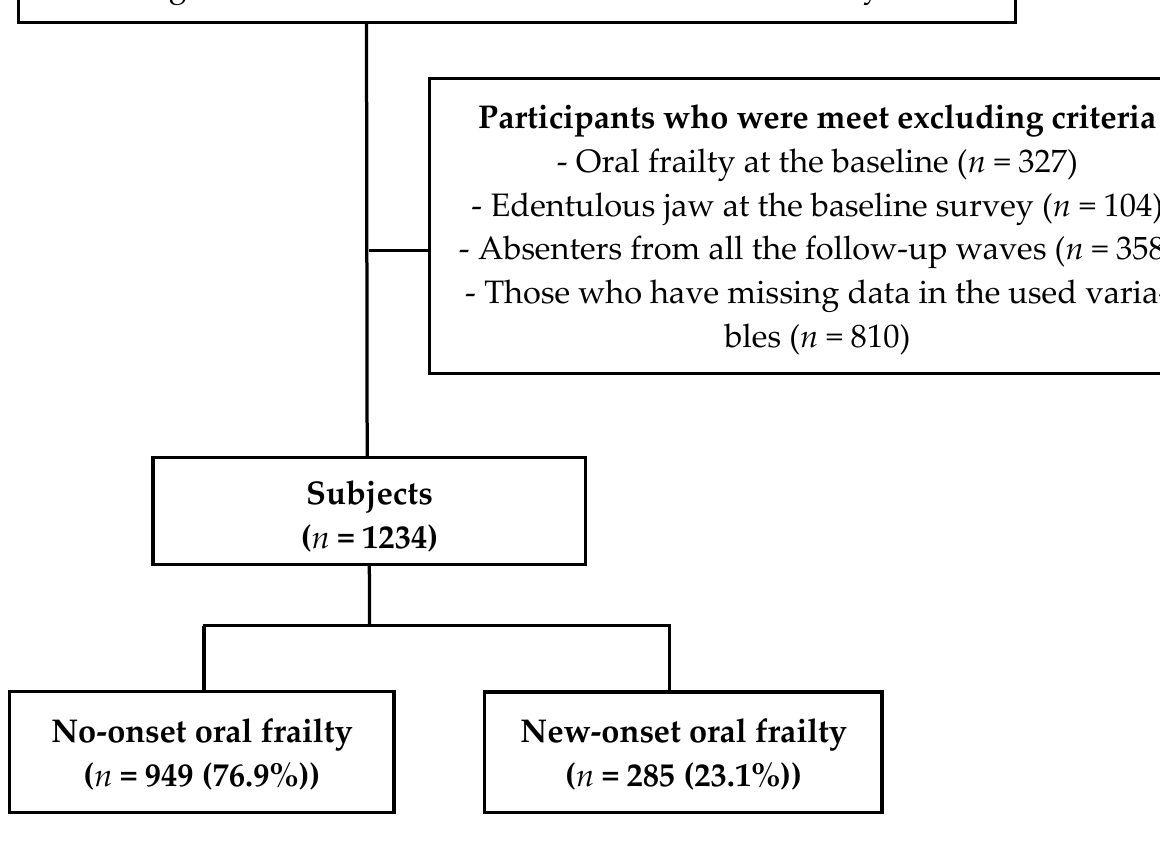
Figure 1. Study flowchart. Table 1. Comparison of basic characteristics at baseline with and without new-onset of oral